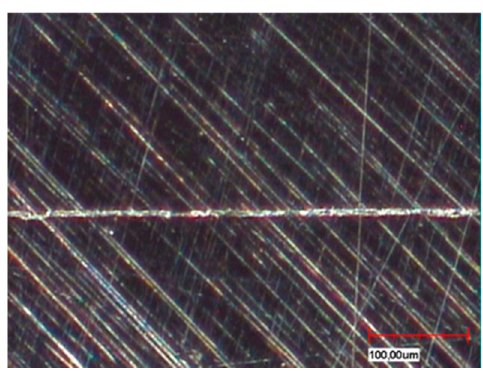
Figure 6. Cut surface of cast Au telescope, occlusal gap ~110 µm and comparatively wavy shape of the inner surface of the secondary crown.